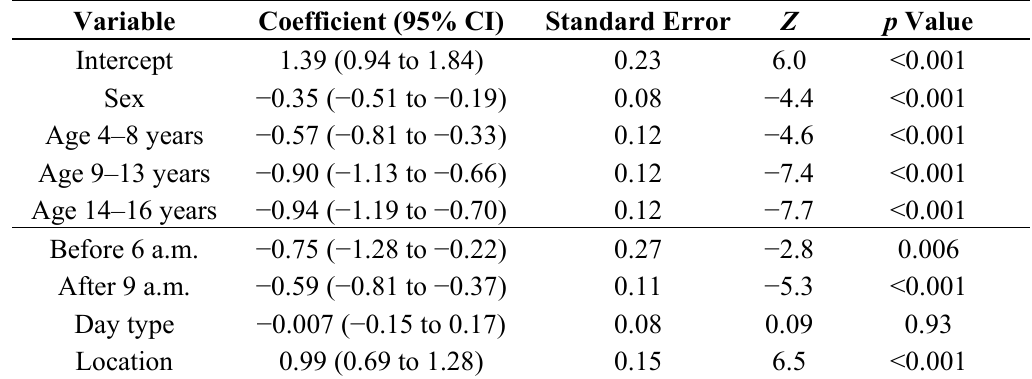
Table 3. Multiple logistic regression for a dairy food being consumed by children ( n = 4467) at the first eating